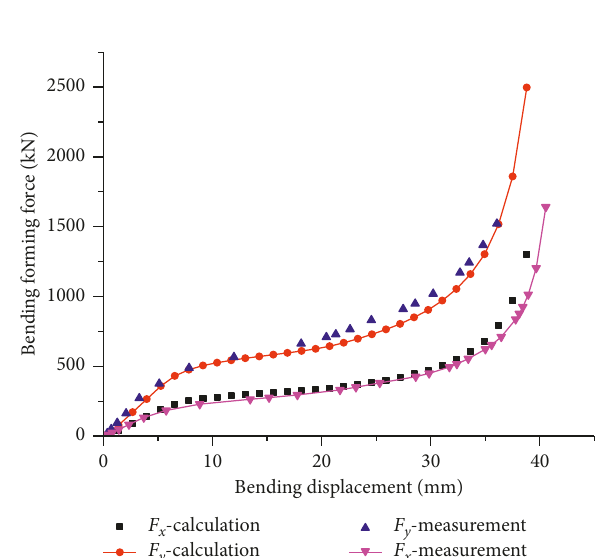
Figure 2: Verification with bending force.